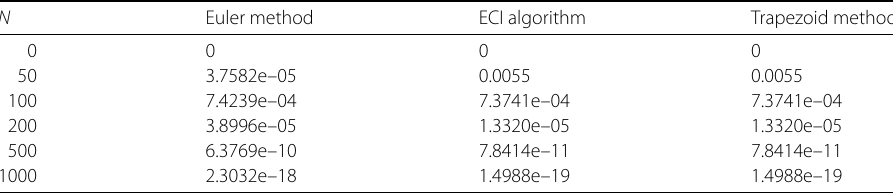
Table 2 Comparison of errors for different number of steps, N , obtained by different methods N Euler method ECI